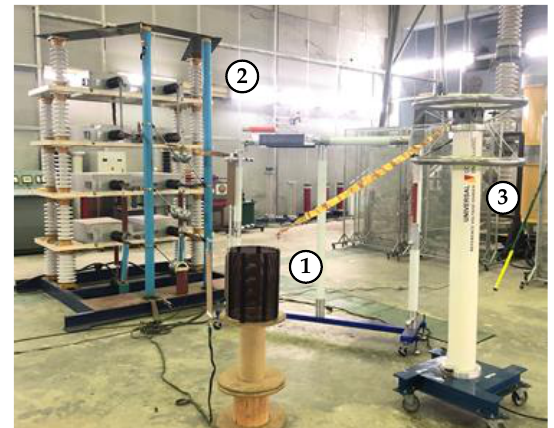
Figure 13. Equivalent circuit of the completed test system for the lightning impulse test of the reactor.